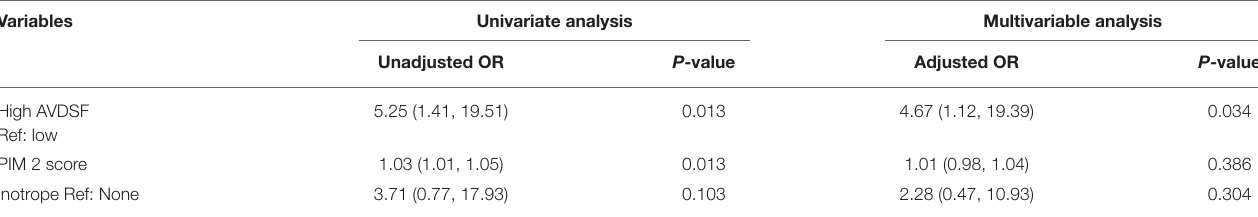
TABLE 3 | Univariate and multivariable logistic regression for intensive care unit mortality.